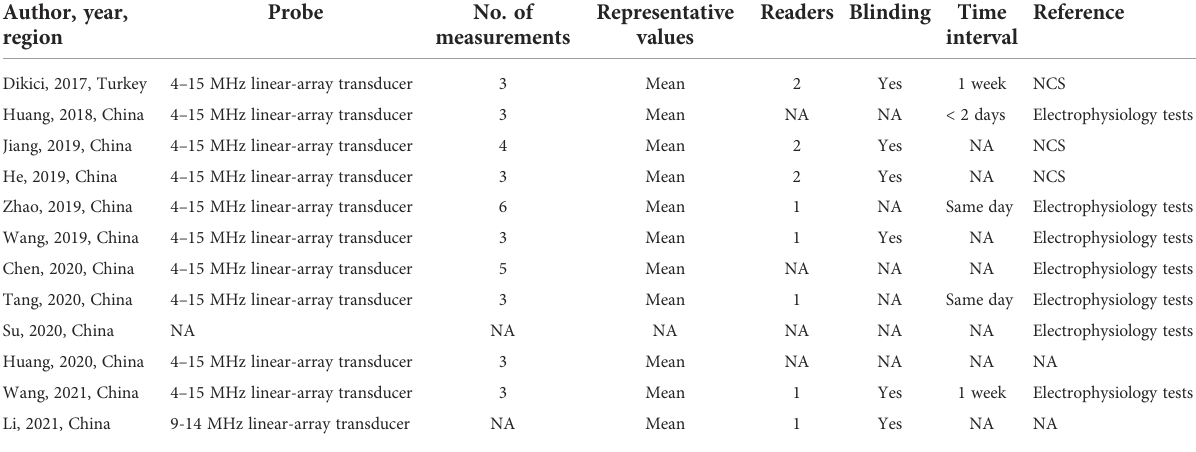
NA, not available; NCS, nerve conduction study; SSI, supersonic shear wave imaging.